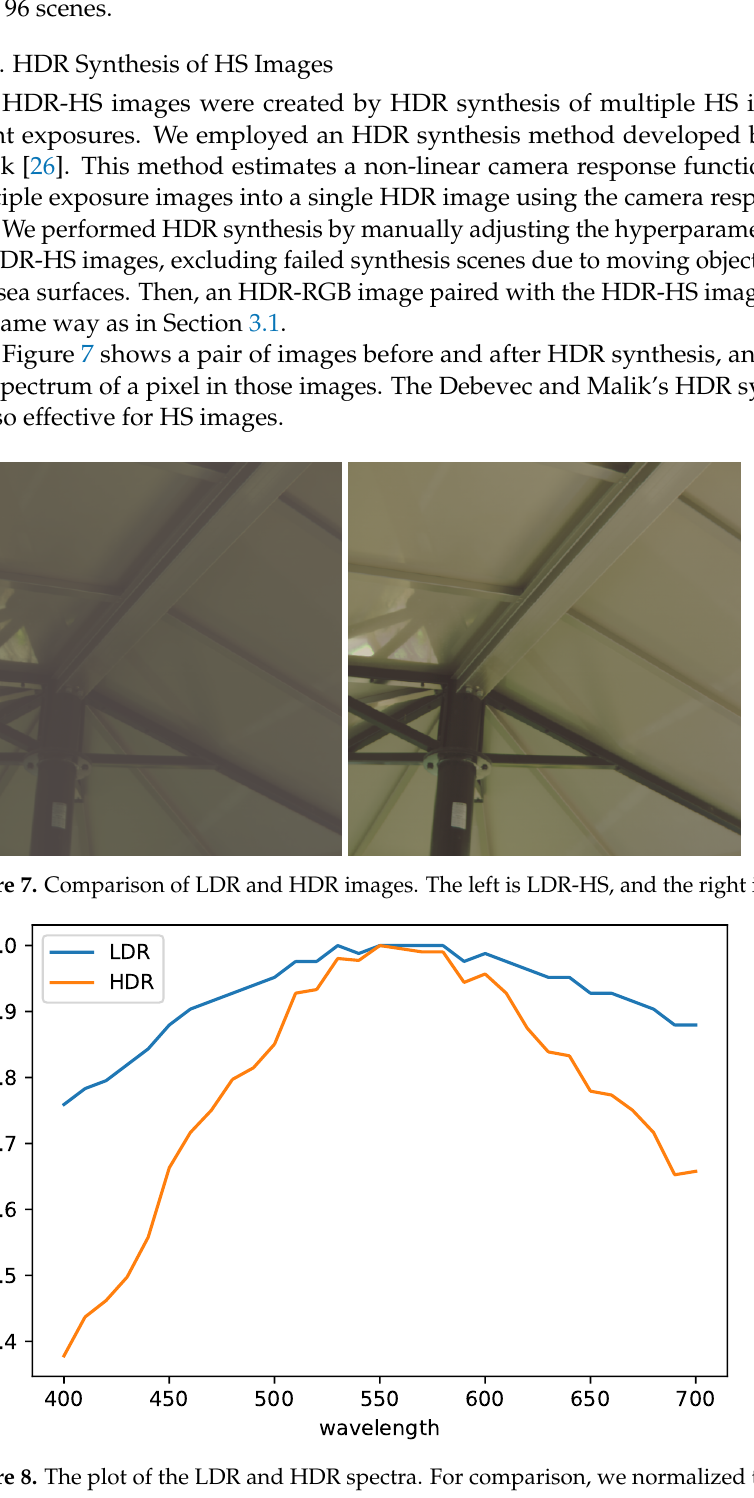
Figure 8. The plot of the LDR and HDR spectra. For comparison, we normalized the spectra so that the maximum value is